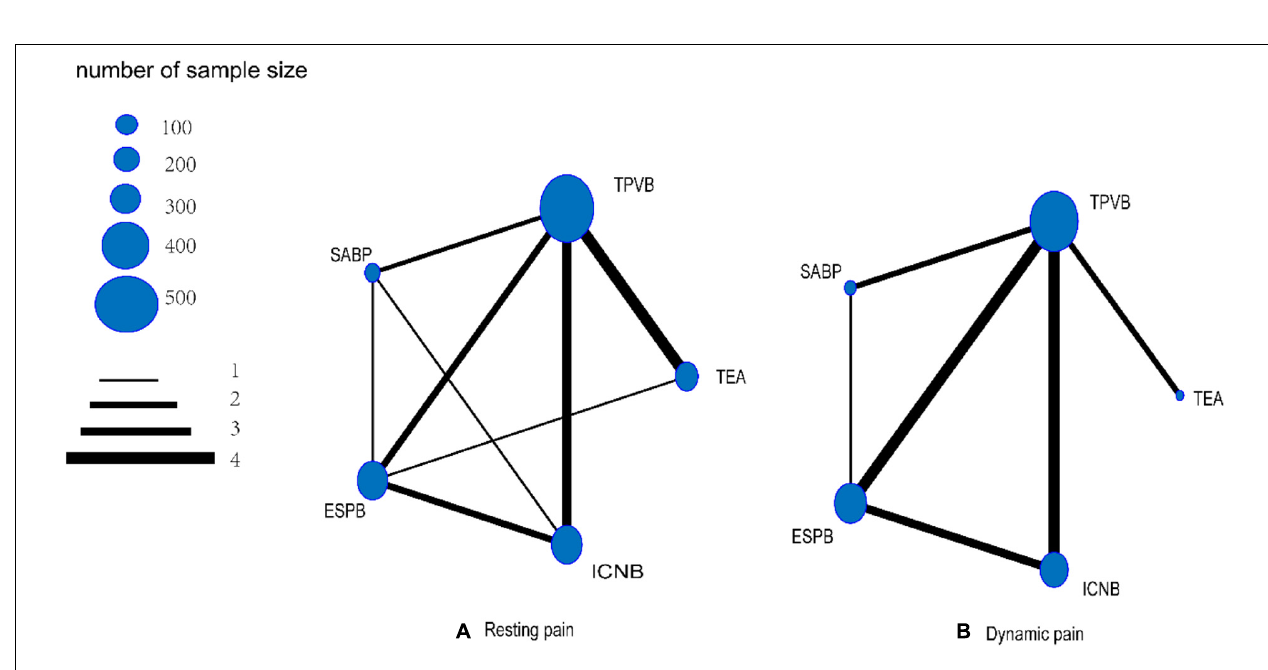
FIGURE 2 | Network